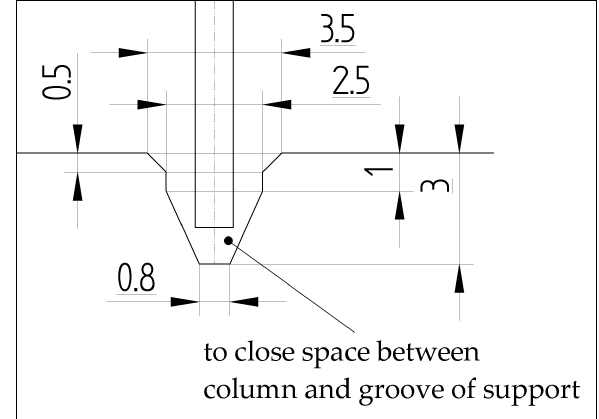
Figure 5. The way of support of column edges in the groove of the plate.